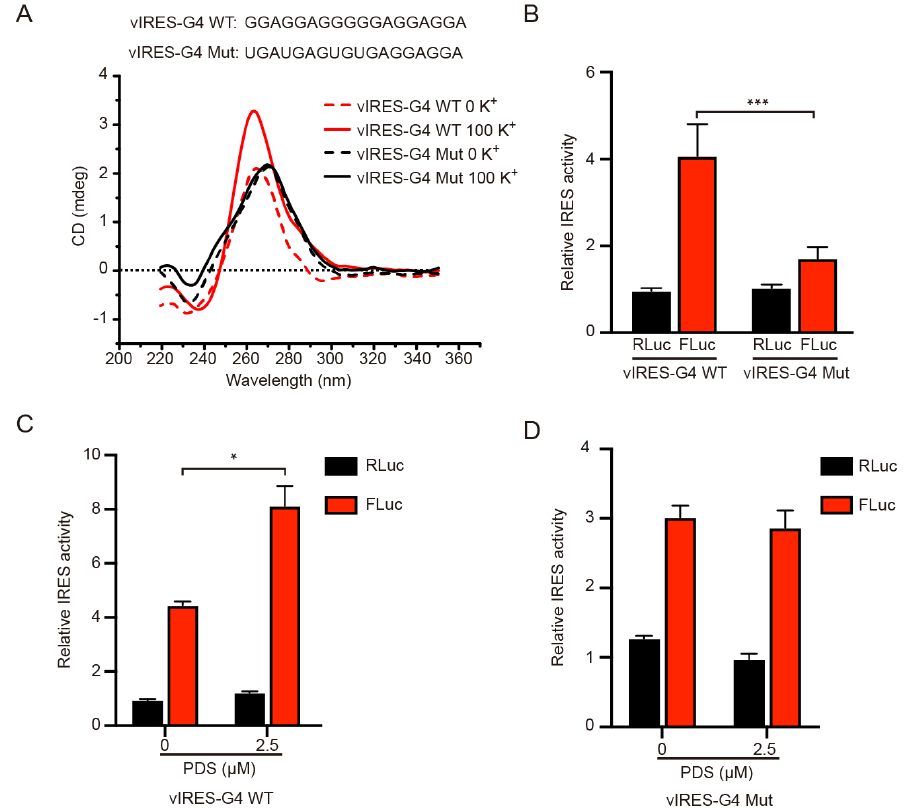
Figure 2. Effect of G4 structure on the individual luciferase activity. ( A ) CD analysis of the wild type and mutant G4 sequence in the vIRES vector in the absence or presence of 100 mM K + . ( B ) The influence of the G4 mutation on the FLuc luciferase activity. PDS treatment significantly enhanced the FLuc luciferase activity of the wild type G4 ( C ), but not the mutant G4 ( D ). * indicates significant difference at p < 0.05; *** indicates significant difference at p < 0.001.